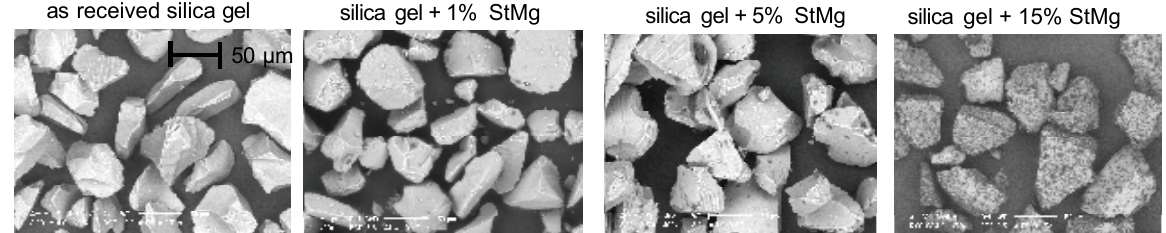
-silica gel coated 2